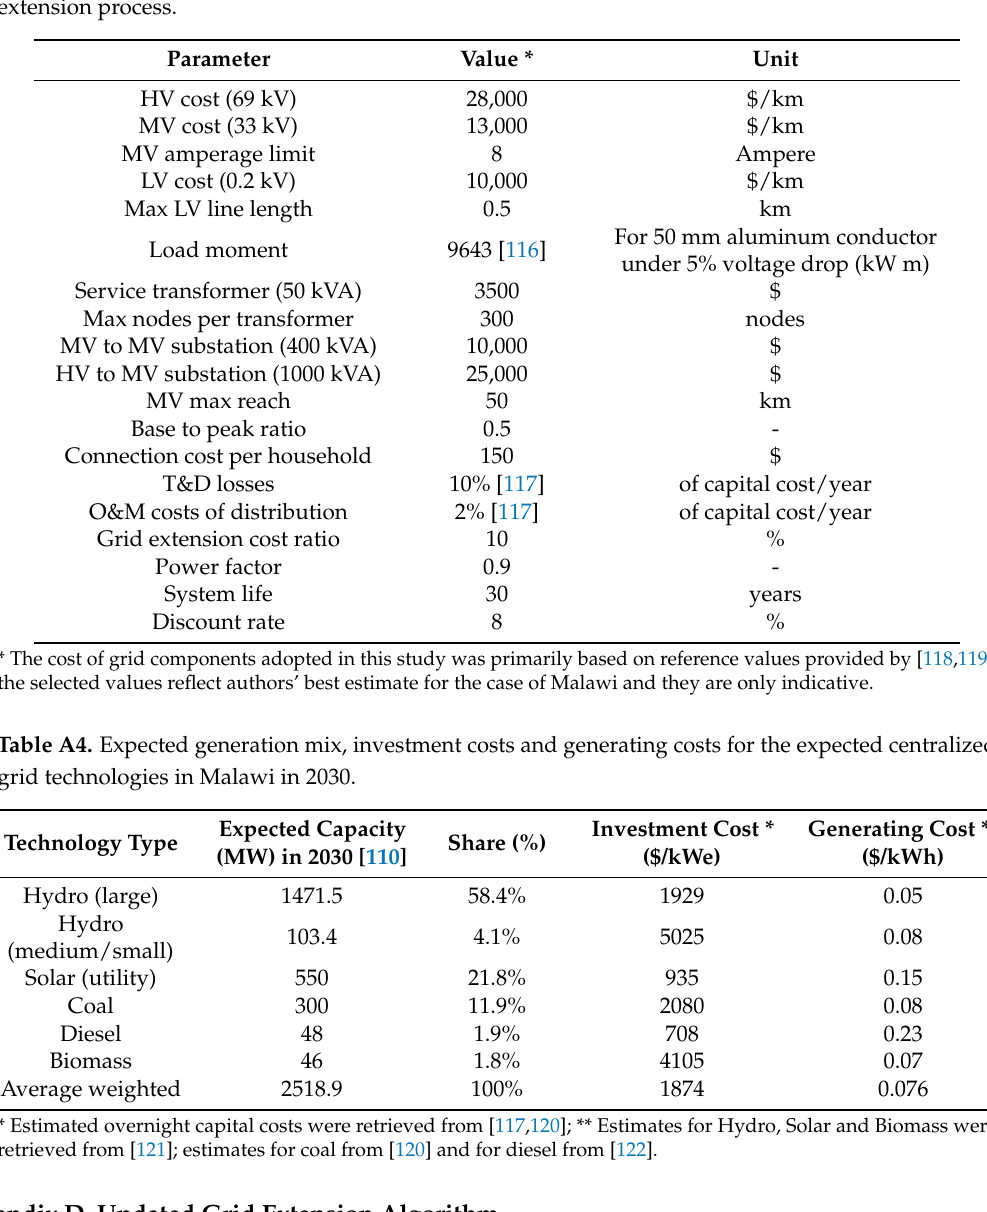
Table A3. Techno-economic parameters related to the operation of the centralized grid and its extension process.